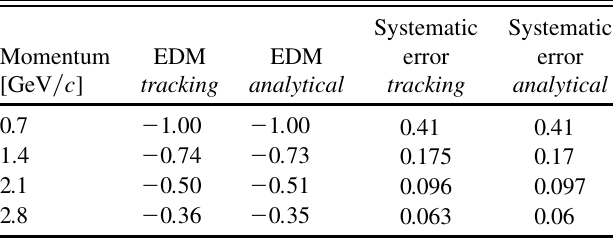
TABLE II. Comparison between tracking results and analyti- cal estimations for the proton case, in rad = s .